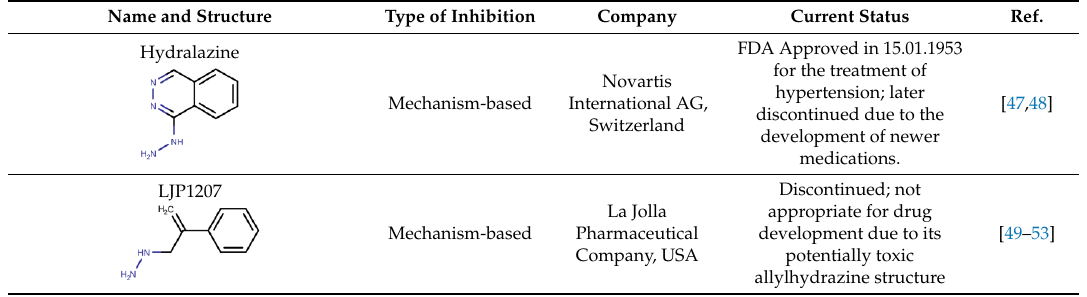
Table 1. List of hVAP-1 inhibitors in ongoing or completed clinical trials as of 15 January 2020.